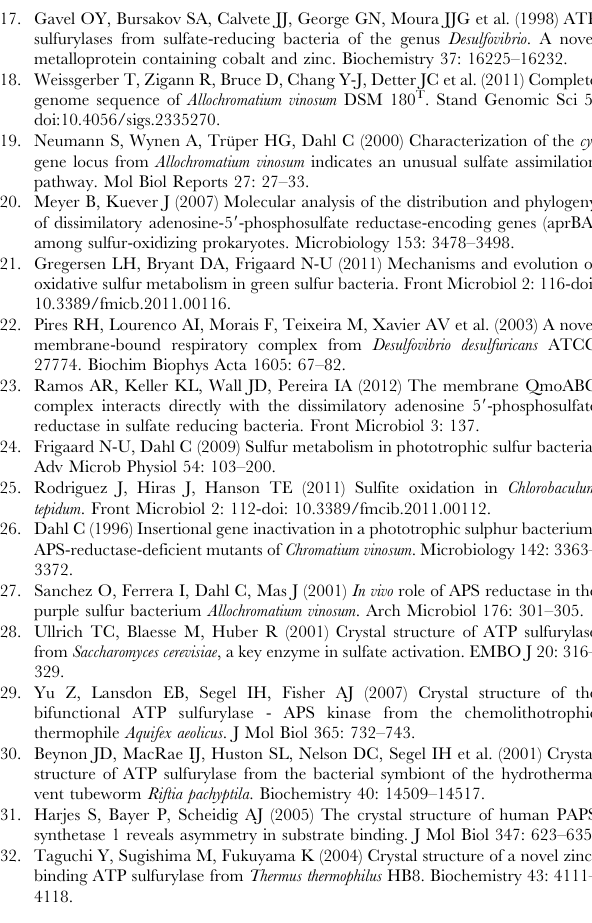
(Table 1) [43]. Soaking and co-cystallization attempts with APS, ATP or ATP analogues and MgCl 2 failed.